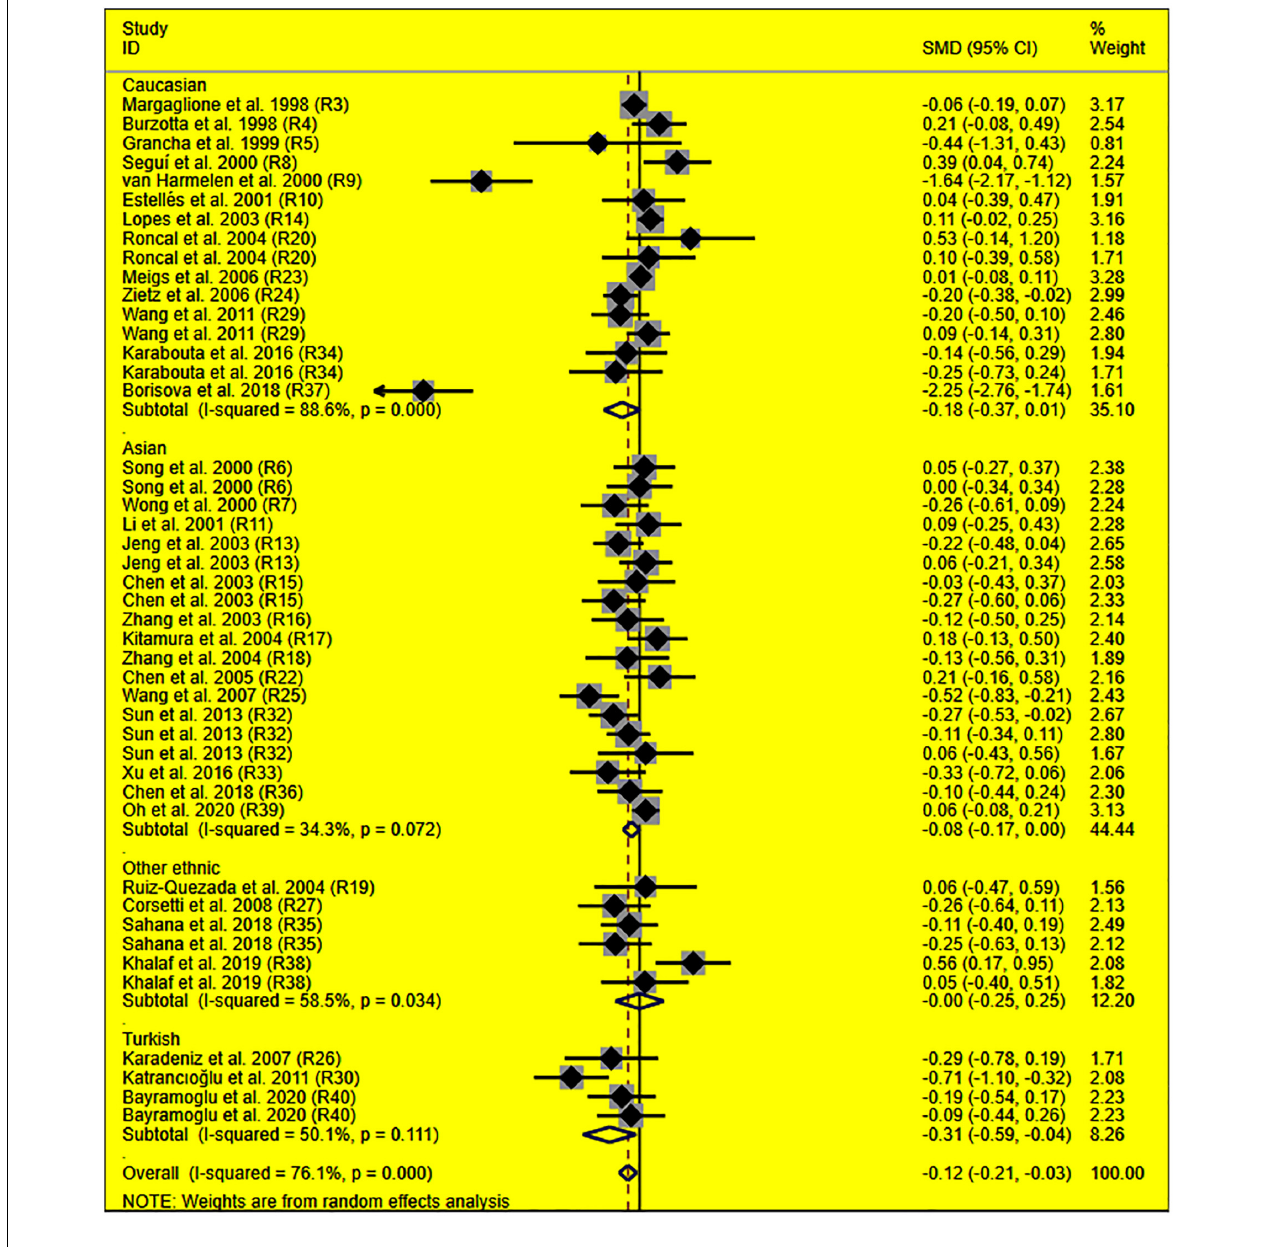
FIGURE 4 | Forest plot of the meta-analysis between SERPINE1 rs1799889 polymorphism and circulating TG